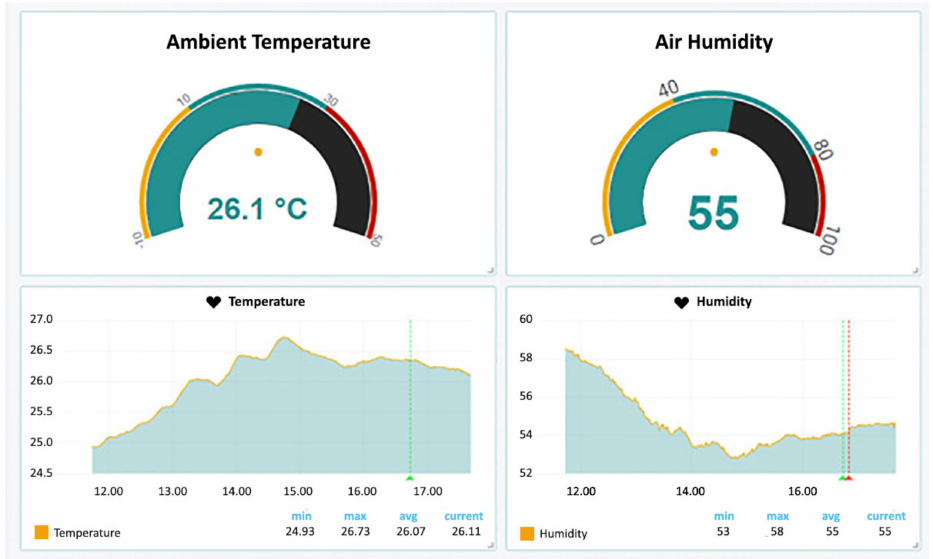
Figure 14. Screenshot for ambient temperature and air humidity